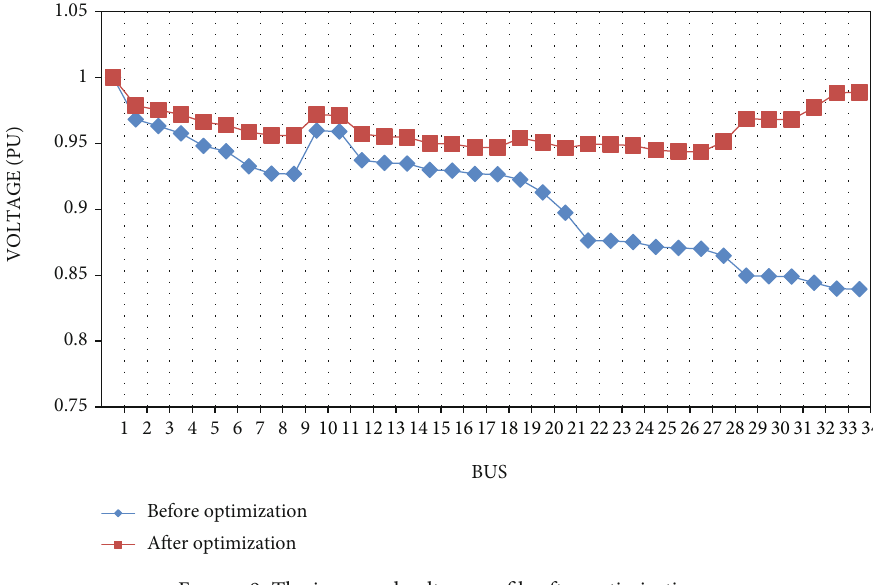
Figure 9: The improved voltage pro fi le after optimization.